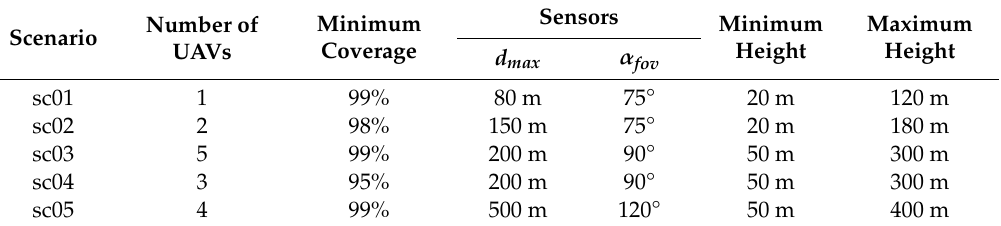
Table 8. Technical and tactical parameters of the reconnaissance